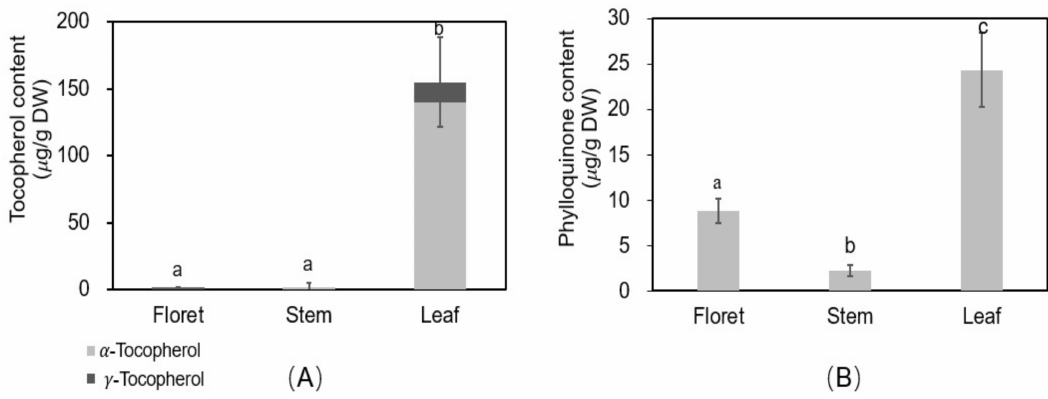
Figure 5. Oil soluble vitamin concentrations in different tissues of broccoli. Tocopherol (vitamin E) ( A ) and phylloquinone (vitamin K1) ( B ); Different letters above the error bars indicate significant differences among the different broccoli tissues by LSD at p ≤